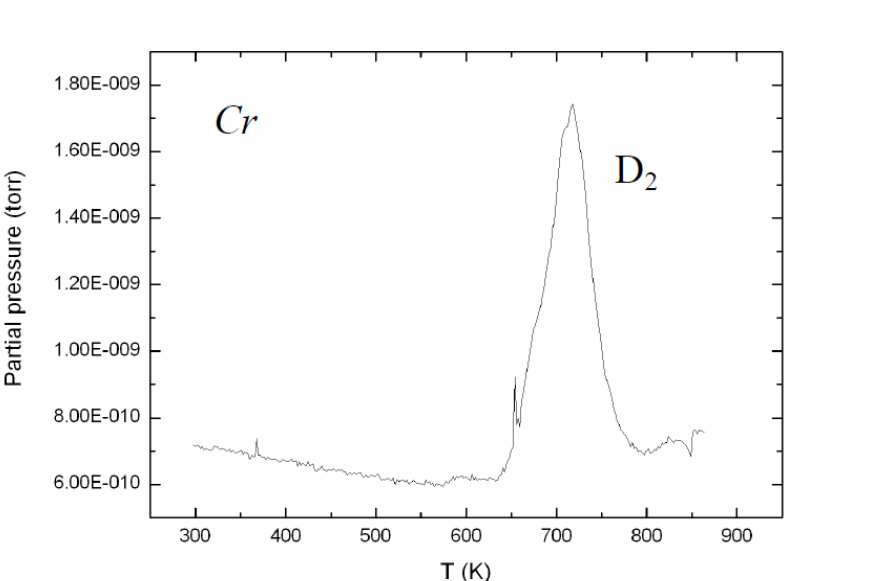
Figure 5 – Thermal desorption spectra of deuterium from Cr exposed to deuterium plasma at 300 K with a fluence of F = 6×10 24 Dm -2 . The temperature ramp was 0.3 K/s. Slika 5 – Spektar termalne desorpcije deuterijuma iz uzorka Cr izloženog plazmi deuterijuma na 300 K i pri fluksu F = 6×10 24 Dm -2 . Temperaturski koraci bili su 0.3